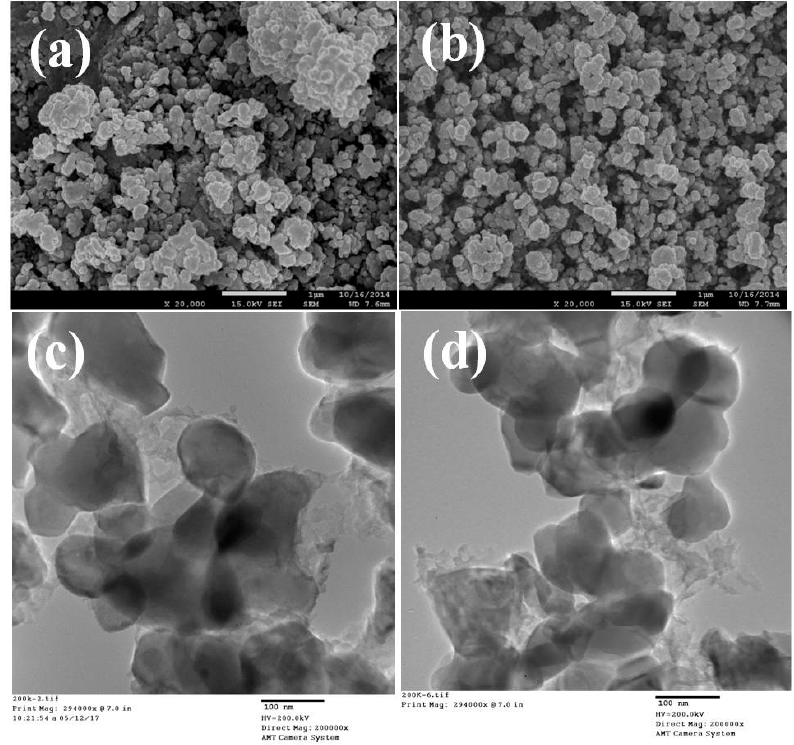
Figure 2. SEM images of ( a ) In-LFP-600 and ( b ) In-LFP-700 samples and their corresponding TEM images ( c , d ). The scale bars in ( a , b ) represent 1 μ m and 100 nm in ( c , d ).